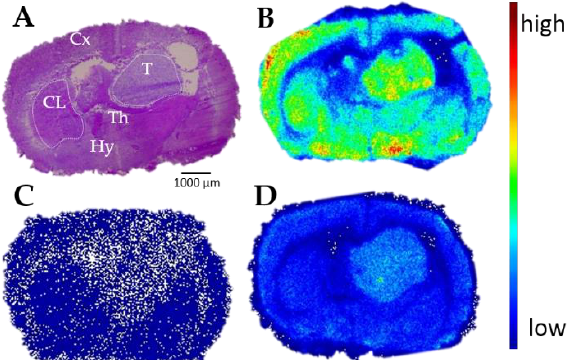
Figure 2. In vitro autoradiography of the mouse brain bearing an orthotopic U87-MG xenograft. Representative autoradiographic images of the coronal plane of mouse brain slices: ( A ) Hematoxylin-eosin staining; ( B ) in vitro distribution of activity after incubation with 0.1 MBq/mL (S)-( − )-[ 18 F]fluspidine, ( C ) co-incubation with 10 µ M SA4503 to determine the nonspecific binding and ( D ) with 10 nM of (S)-( − )-fluspidine as competing agent. Cx: cortex; CL: contralateral striatum; Th: thalamus; Hy: hypothalamus; T: tumour. Width of a mouse brain ~1 cm.